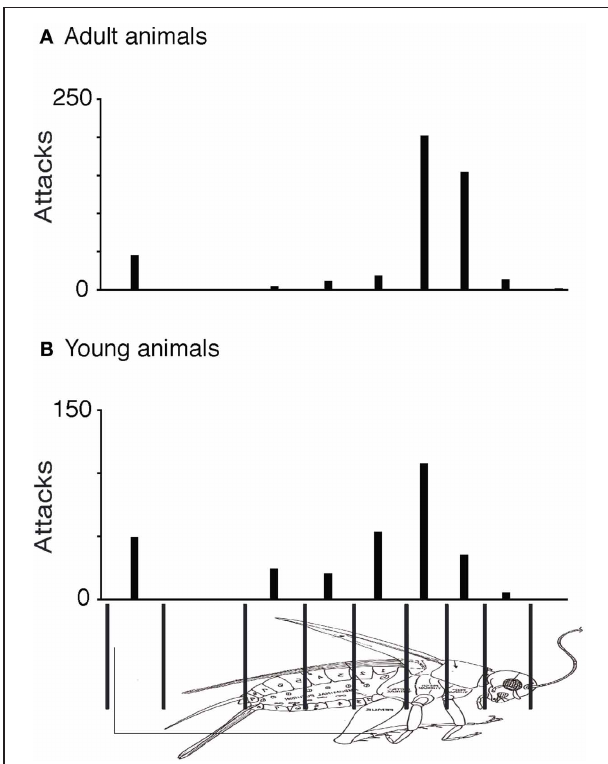
FIGURE 2 | Further attack characteristics in adult and young shrews. (A) Comparison of aborted and completed attacks in adult and young animals. The fraction of aborted and completed attacks in adult and young animals was not significantly different (Fisher’s exact test, two-tailed, p > 0 . 7). (B) Repeated attacks (attacks that immediately follow one-another without intervening breaks or attacks on other prey animals). Adult animals attacked the same cricket repeatedly more often than the young animals. The number of repeated attacks in was significantly higher adult than young animals [ n = 209 first attacks (adults) vs. 202 first attacks (young animals), unpaired t -test, two-tailed, p < 0 .